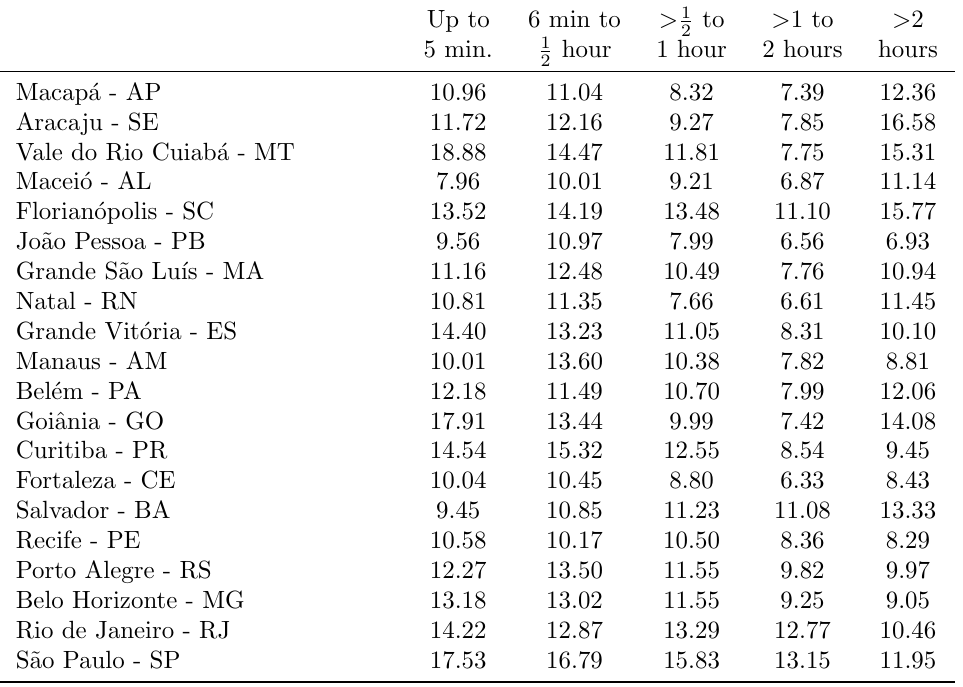
Table A.2: Average individual hourly wage (in Brazilian real) by commuting time from home to work, 2010.